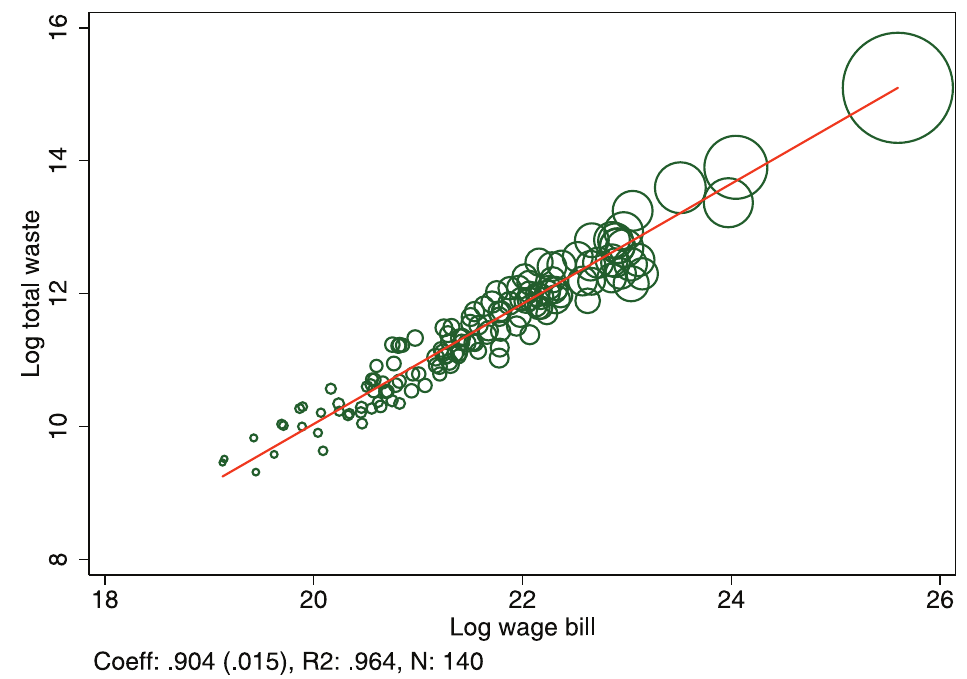
Fig 4. The urban waste premium. Total waste generated and its scaling with respect to total wage bill. Each dot represents a UK Travel to work area. The scaling coefficient was estimated by OLS and the standard error is shown in parentheses.